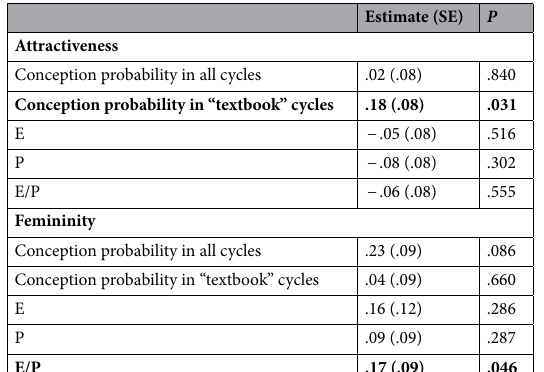
Table 3. Associations between choice on the 3AFC task and ratings task for each of the separate models (statistically significant differences in bold).